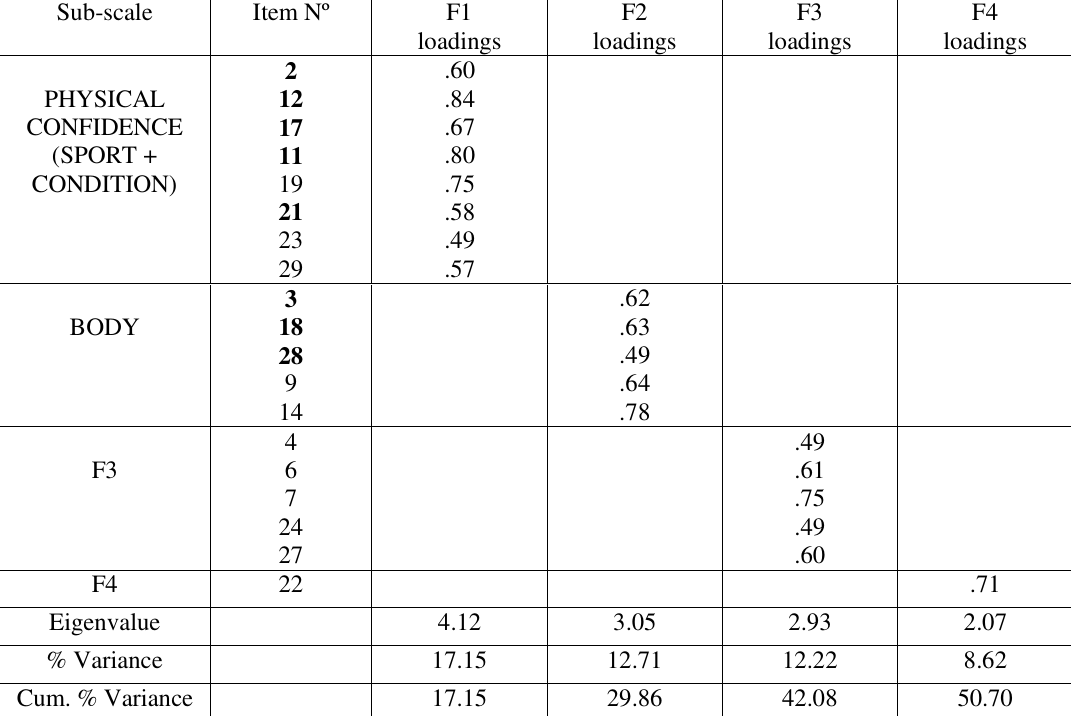
Principal components factor loadings for PSPP items – wheelchair basketball players (n =